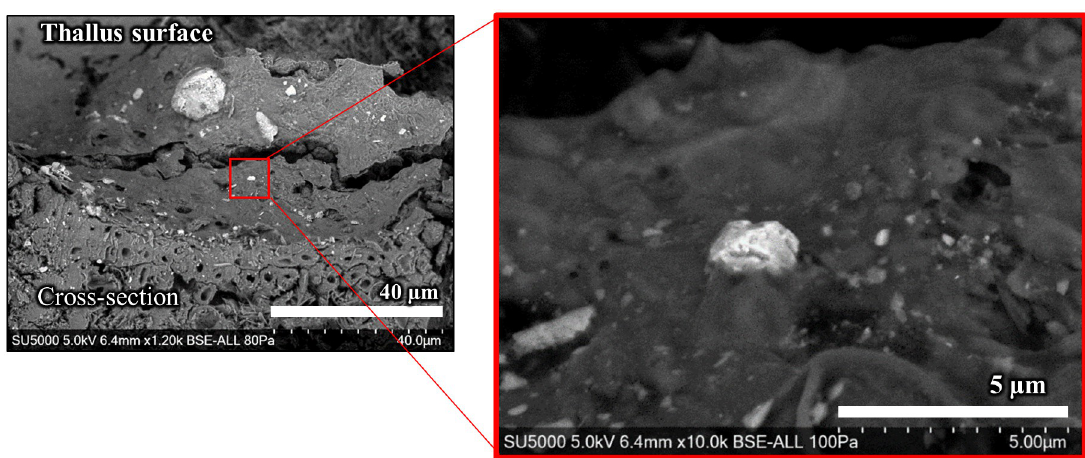
Fig 11. BSE images of the lichen thallus of FY2012PT. Left panel: micron-sized particles entrapped on the lichen thallus surface. Right panel: interaction between a micron-sized particle and the thallus surface. The sample was observed by SE-SEM without any coating. The right panel is a magnified image of the red boxed area in the left panel.